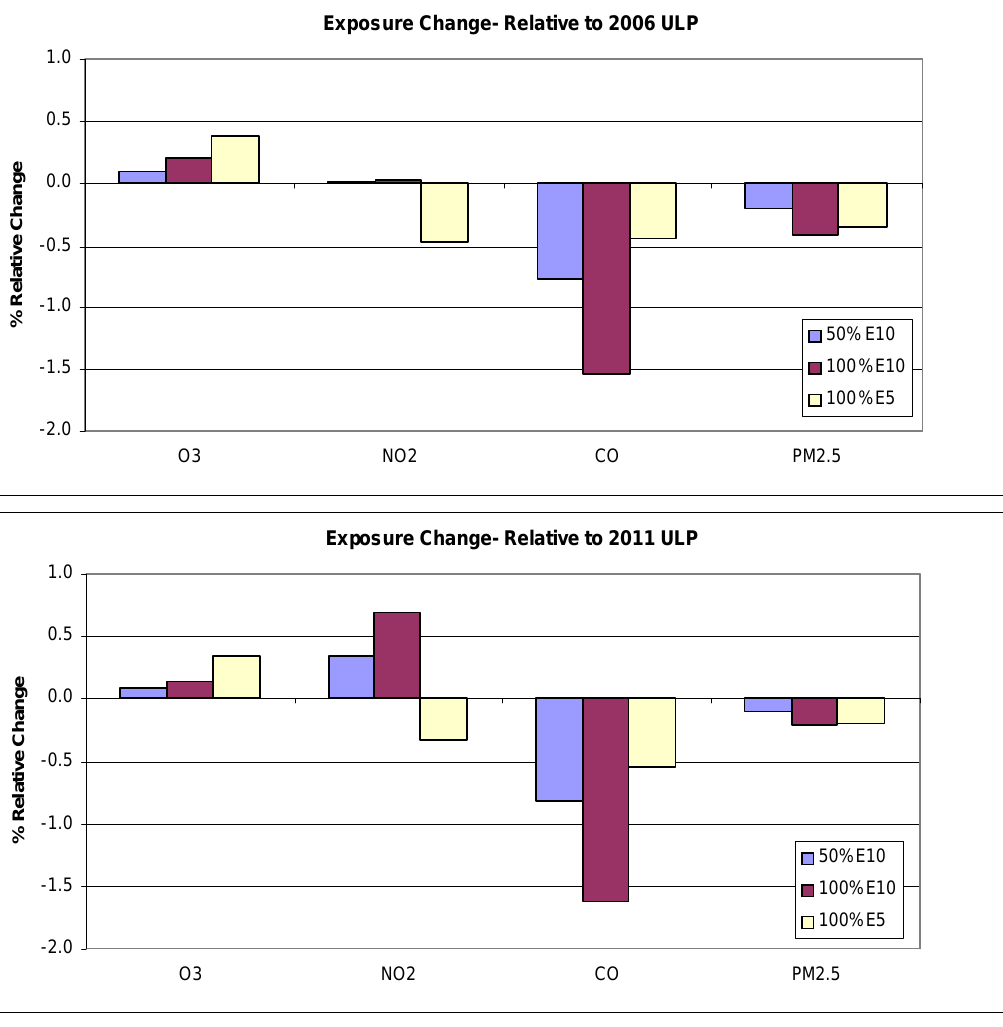
Figure 3. Modelled relative change in population exposure for 2006 (top) and 2011 (bottom) emissions scenarios. Exposure Change- Relative to 2006